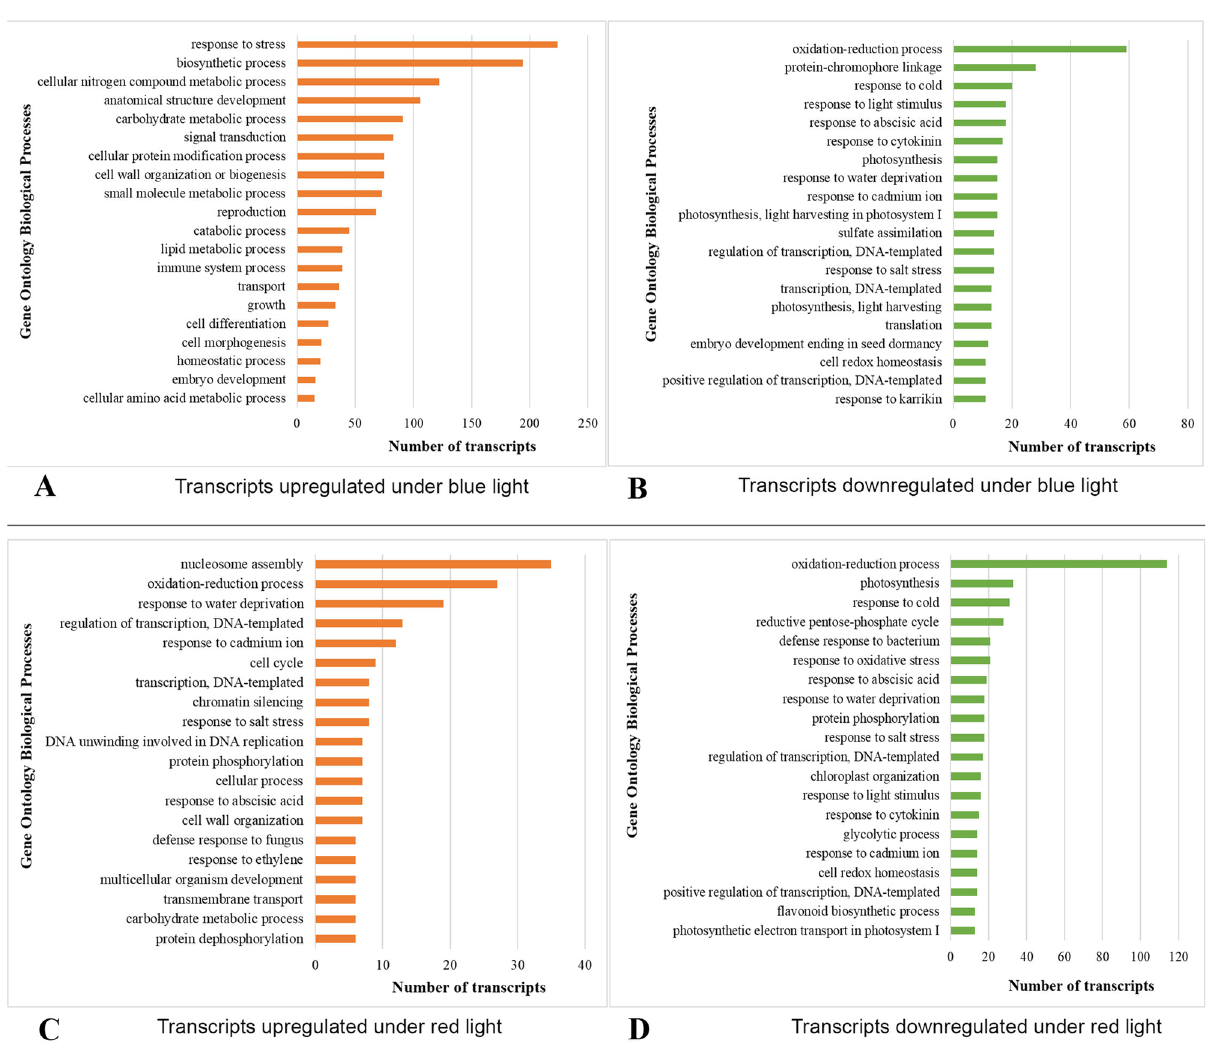
Figure 5. Top 20 Gene Ontology biological processes for differentially expressed transcripts between blue ( A & B ) or red ( C & D ) light treated lettuce. ( A ) Transcripts upregulated in leaf tissues of lettuce grown under blue light; ( B ) Transcripts downregulated in leaf tissues of lettuce grown under blue light; ( C ) Transcripts upregulated in leaf tissues of lettuce grown under red light; ( D ) Transcripts downregulated in leaf tissues of lettuce grown under red